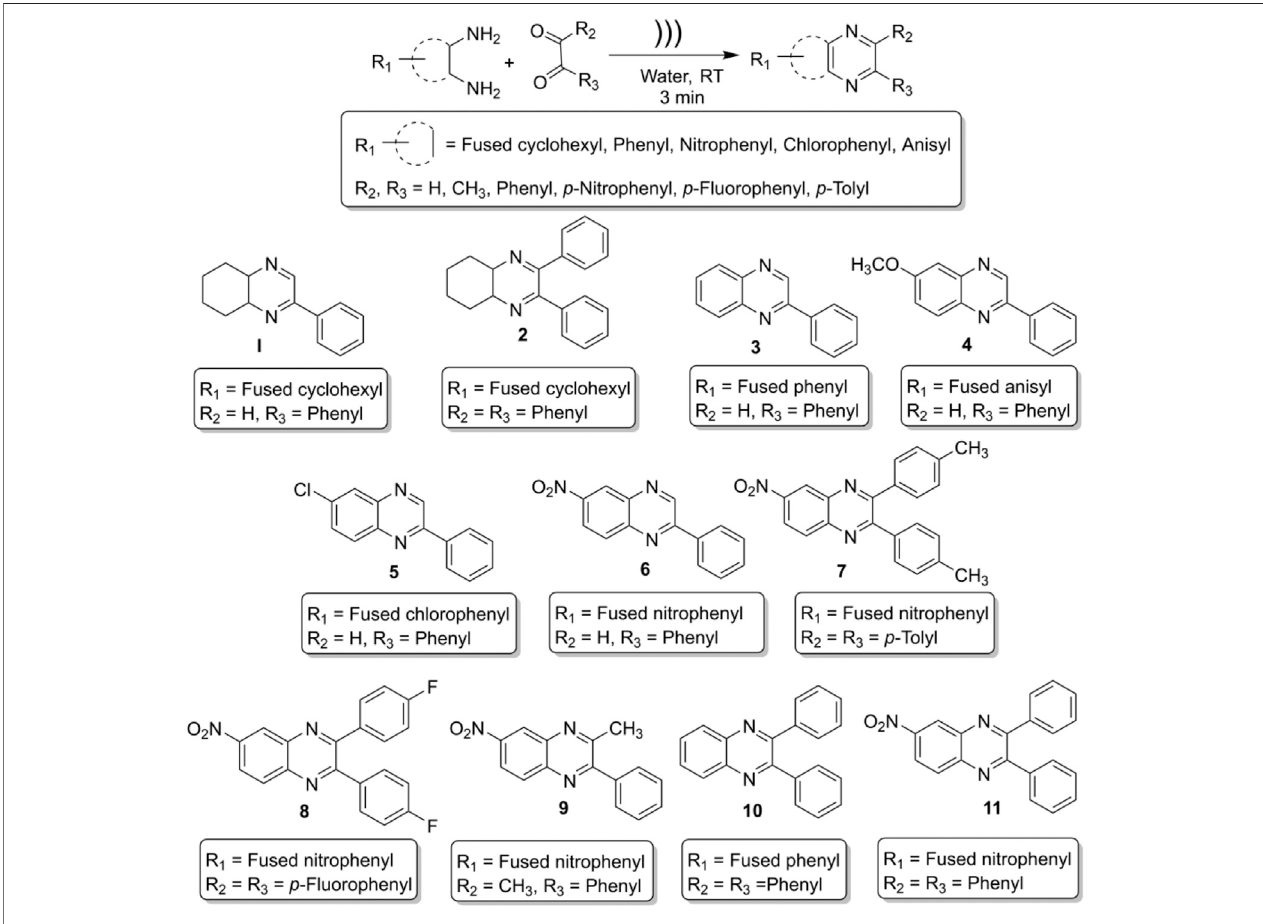
(neat) without making pallets. 1 H NMR (600 MHz) and 13 C